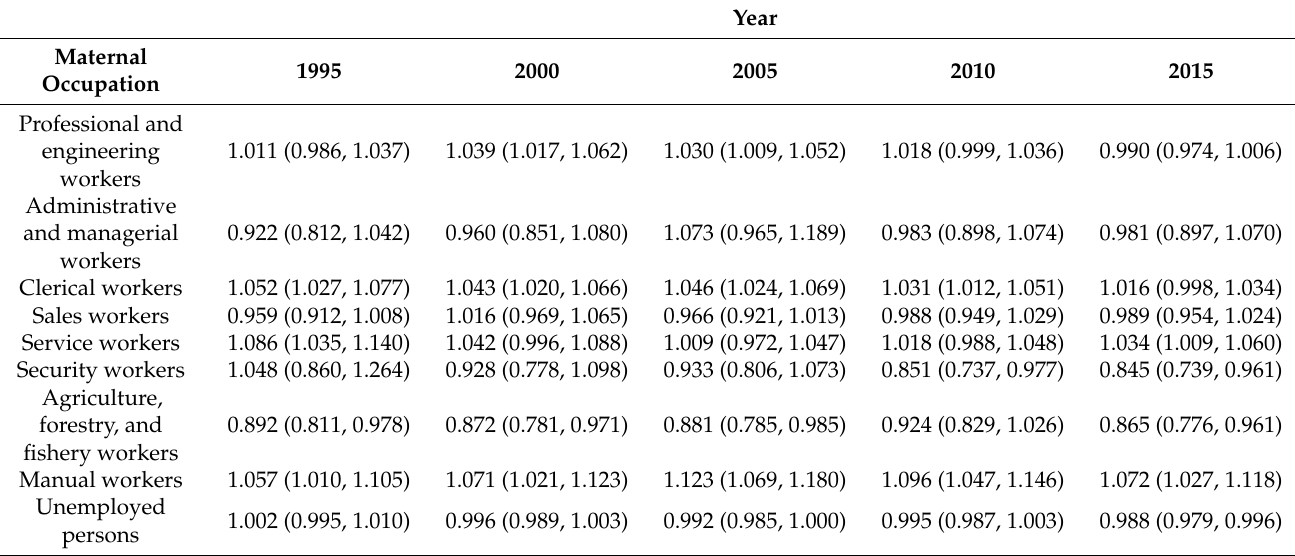
Table 4. Standardized low birth weight ratio and its 95% confidence intervals by maternal occupation for each